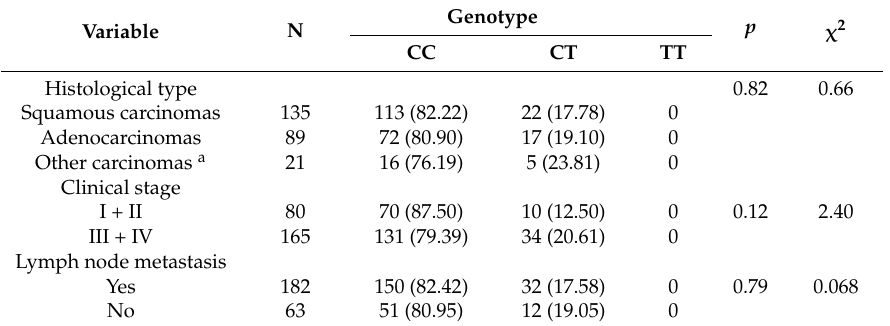
Table 6. Correlation between MMP9 and clinical pathology parameters in